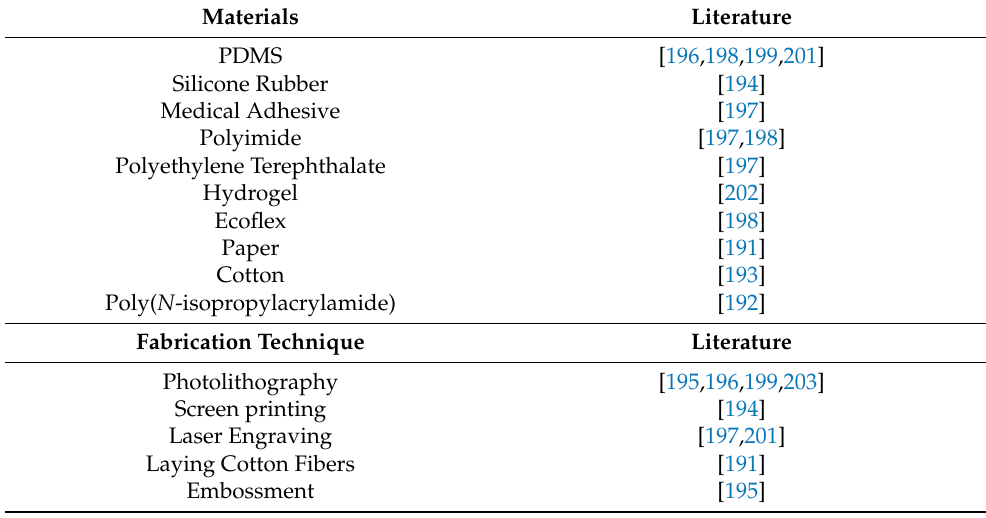
Table 4. Biocompatible materials and fabrication techniques for microfluidic-based wearable